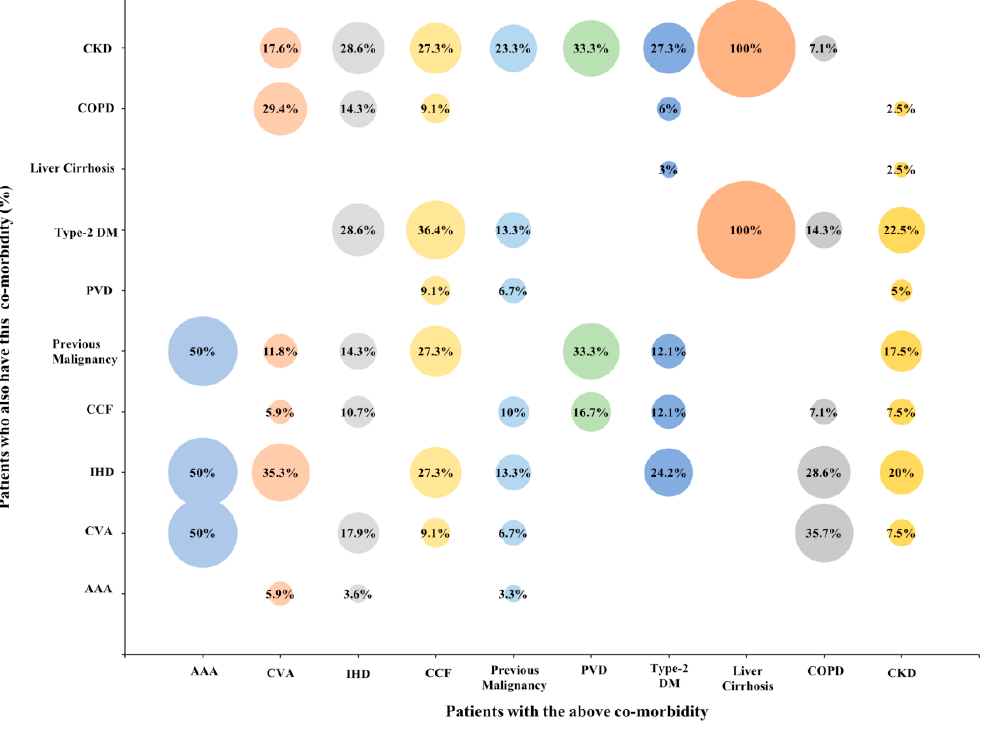
Figure 3. The percentage of patients with one significant comorbidity who have another significant comorbidity.